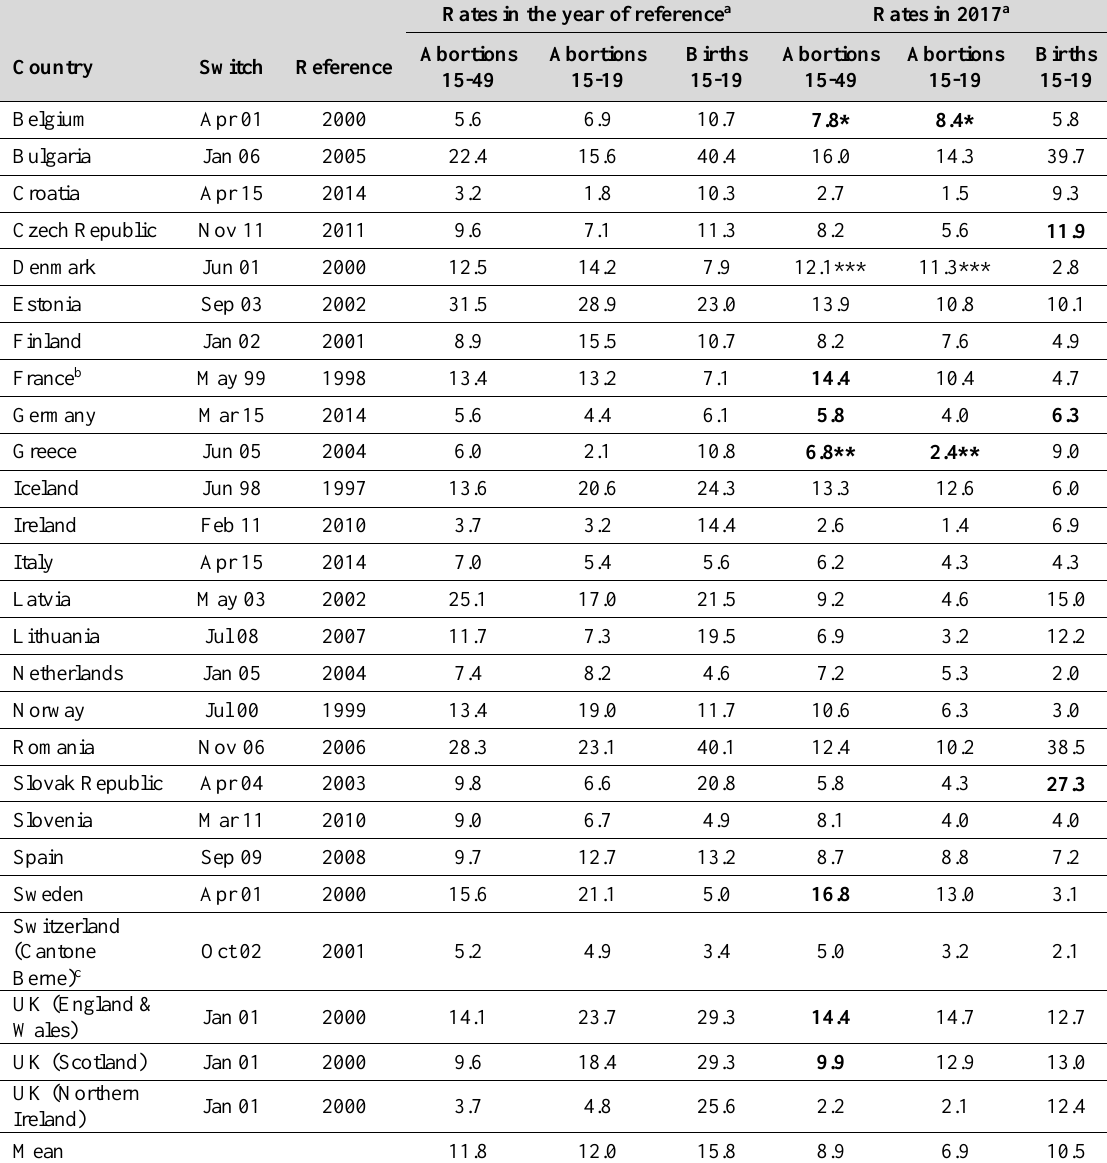
Table 1. Induced abortion and live birth rates at time of the OTC switch compared with rates in 2017 Rates in the year of reference a Rates in 2017 a Country Switch Reference